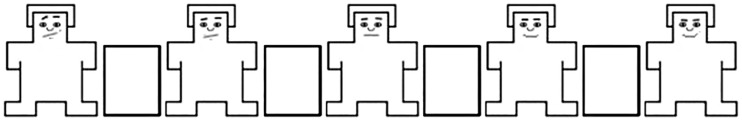
The additional dimension of certainty.